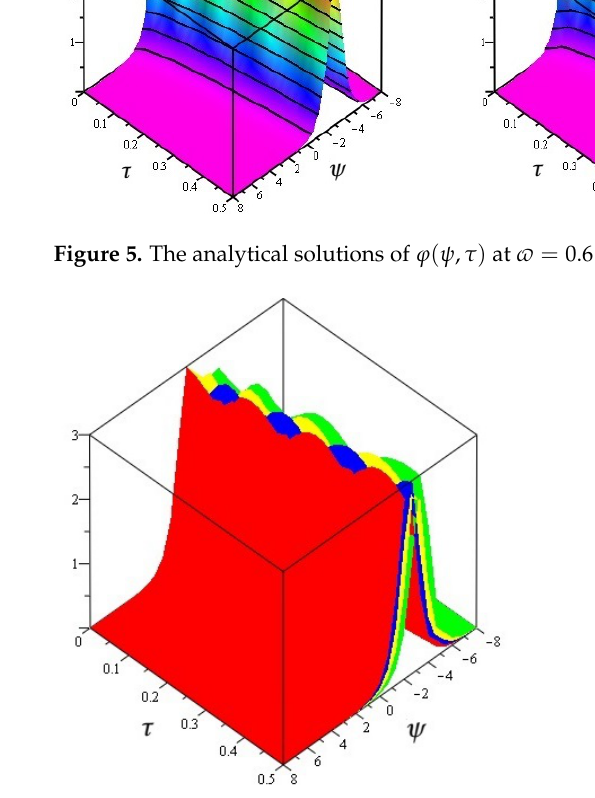
Figure 6. The different fractional-order of (cid:118) of ϕ ( ψ , τ )